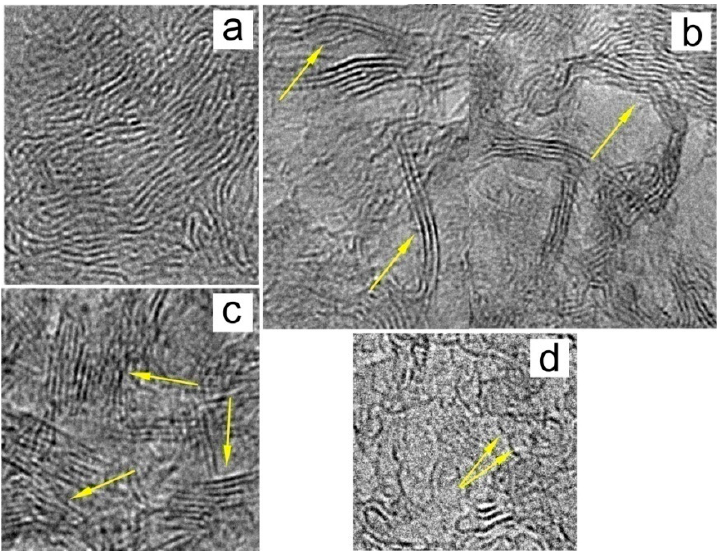
Figure 3. Basic structures of D sp 2 C: ( a ) typical entangled structure, ( b ) ribbon structure, ( c ) stacks of graphene layers, and ( d ) fullerene-like single-layer and multilayer structures.